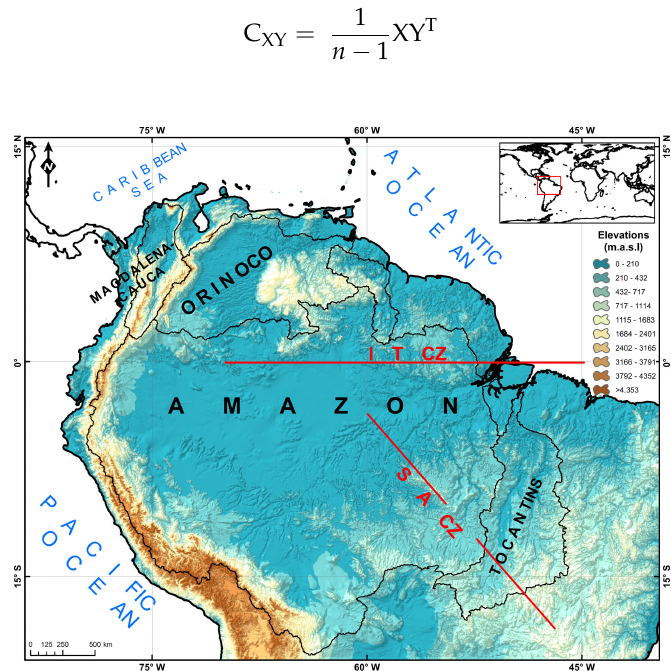
Figure 2. Study region with major river basins included in the analysis: Amazon, Tocantins, Orinoco, and Magdalena. The Intertropical Convergence Zone (ITCZ), and the South Atlantic Convergence Zone (SACZ) are important climate modulators of the